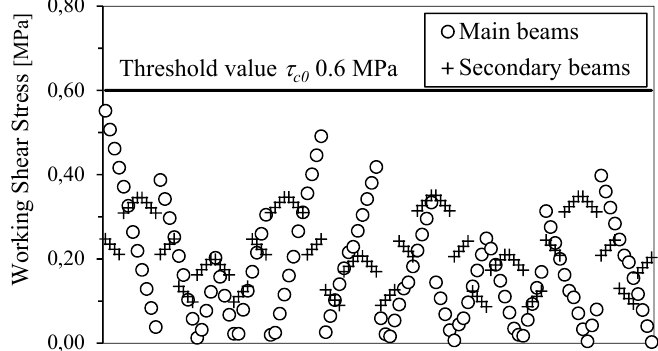
Figure 9. Structural verifications for shear in the